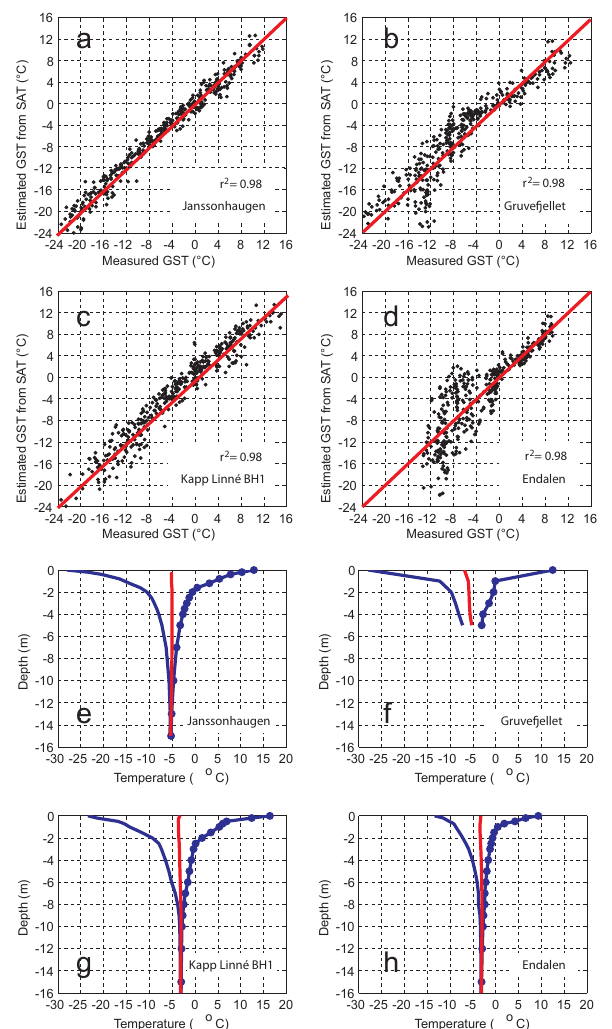
Fig. 3. (a–d) Measured ground surface temperature (GST) plotted against estimated GST based on the surface air temperature (SAT) from Svalbard Airport and a n -factor based transfer function. Only the Endalen site showed a significant effect of snow cover during winter, resulting in a lower but still satisfying r 2 of above 0.75. At the other sites, modelled and observed GST agree well ( r 2 > 0 . 87). (e–h) The red lines represent measured mean ground temperature at various depths for the 2008/2009 period. The envelope of maximum and minimum temperatures is shown by the blue lines. Thermistor locations are indicated by the solid circles.